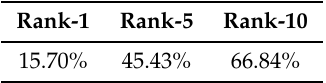
Table 4. SOMAset accuracy at different ranks under cloth variation as achieved by the Inception V3 network.